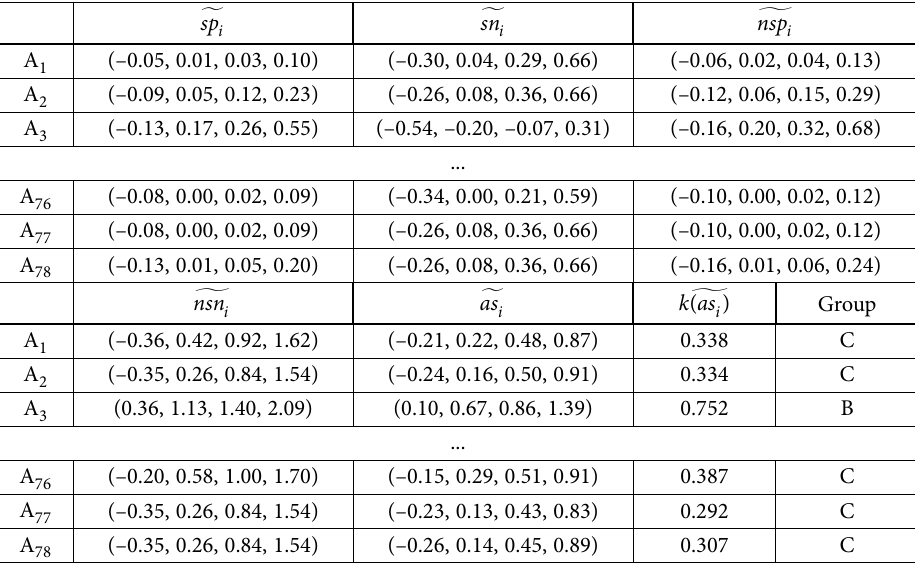
Table 3. The results of novel integrated Fuzzy FUCOM – fuzzy EDAS